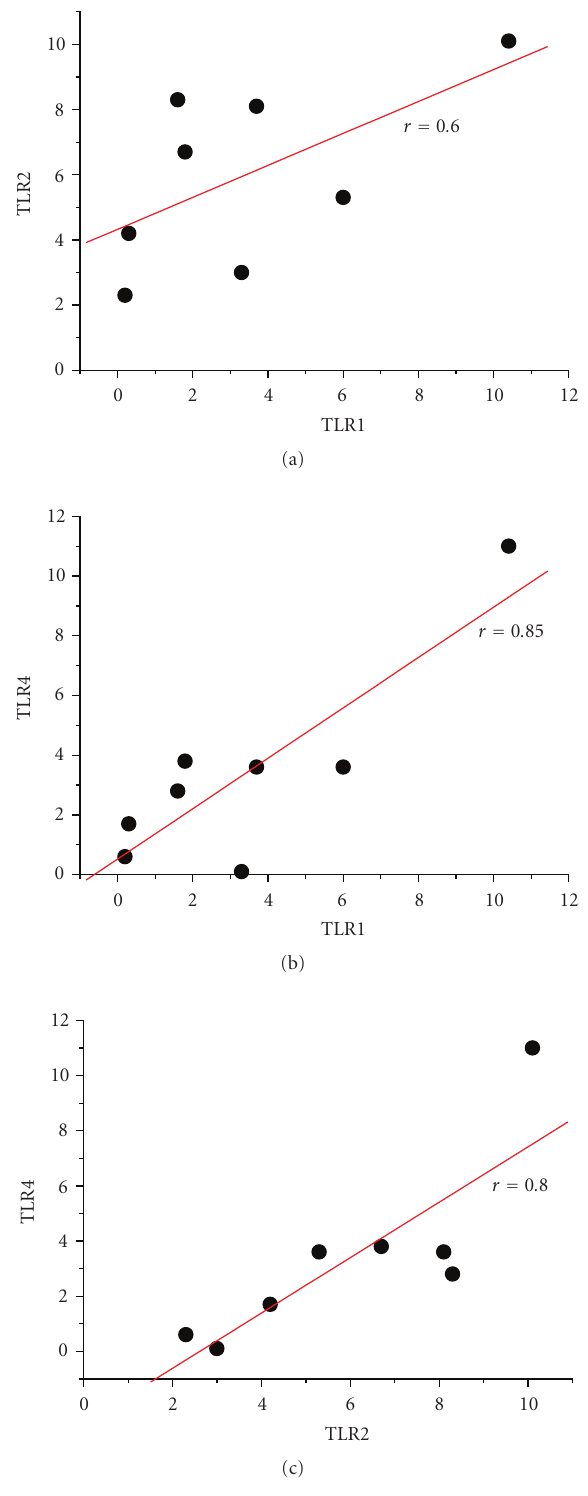
Figure 3: Assessment of linear correlations of TLR expression: TLR expression on CD4+ cells (values represent % TLR1, TLR2 or TLR4 positive CD4+ cells; each dot represents one patient) was plotted and by linear fit analysis the correlation was assessed. With P < . 001, a weak correlation between TLR1 and TLR4 expression was seen, and between TLR2 and TLR4 expression, but not between TLR1 and TLR2.